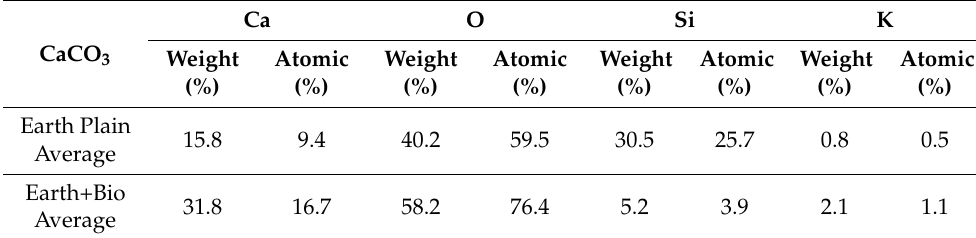
Figure 13. Cement plain mortar ( left ); cem+bio mortar ( right ).